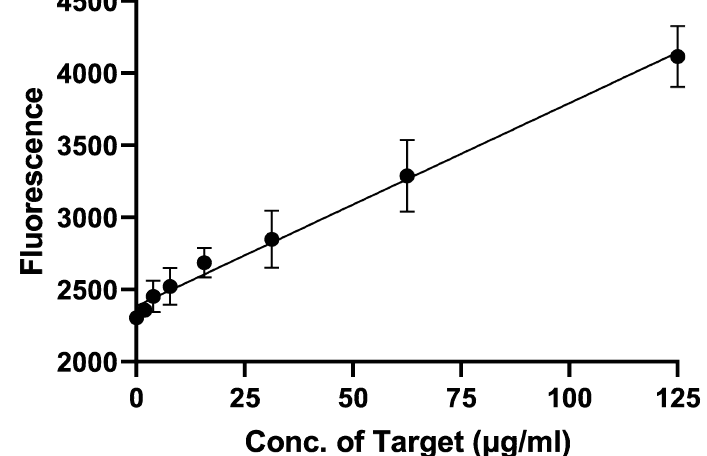
Figure 4. The detection limit of the rGO-GABAS-01 aptanano sensor system. A linear fluorescence response was observed in the range of 0–125 μ g/mL GHSA. The limit of detection (LOD) was determined to be 16.40 μ g/mL using the official formula from the IUPAC (LOD = 3 × SD/slope).